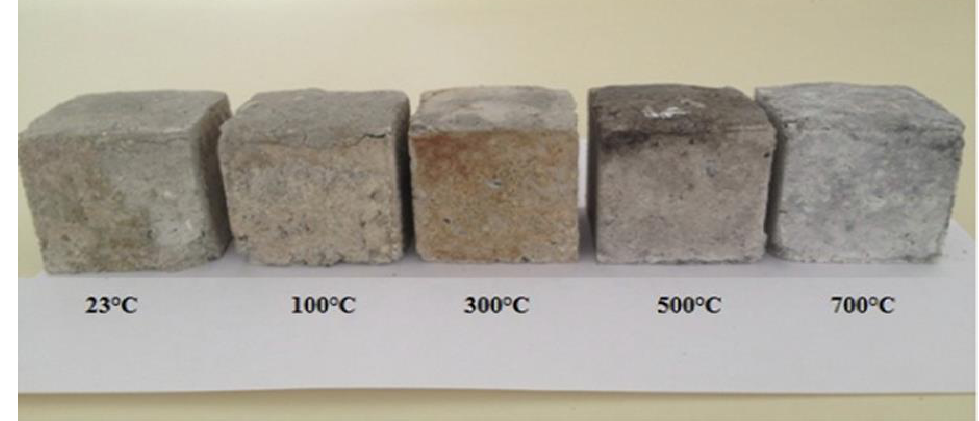
Figure 13. Variation in the appearance of concrete containing 2% NS after different temperatures [120].